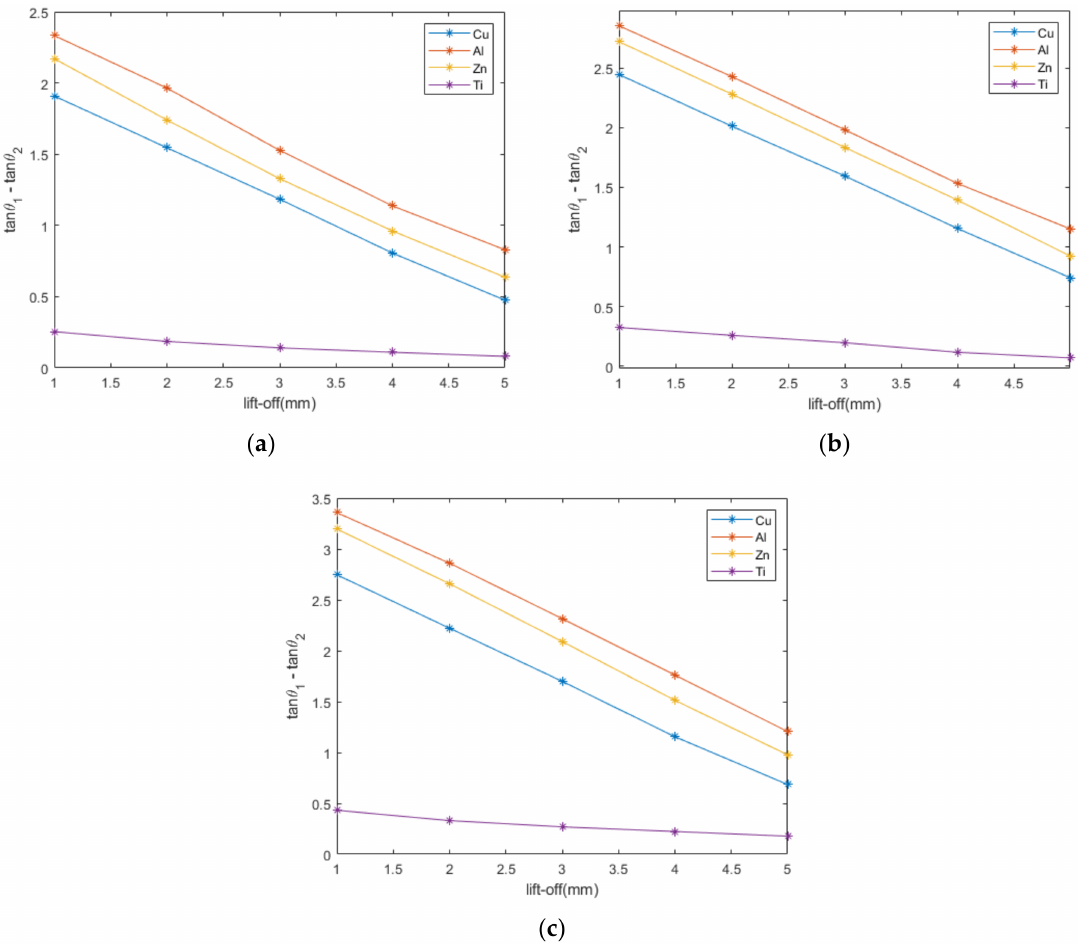
Figure 7. The linearity between the feature and lift-off for different metals at different excitation frequencies: ( a ) 40 kHz; ( b ) 60 kHz; ( c ) 80